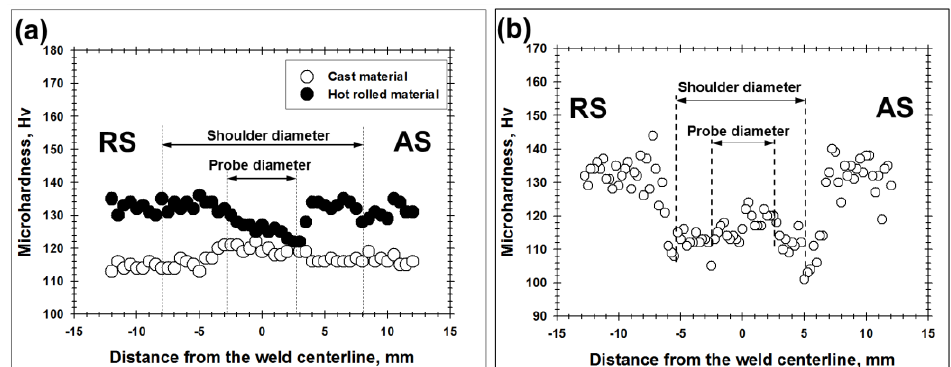
Figure 3. Microhardness profiles measured along the dotted lines shown in Figure 1 in ( a ) Al-Mg-Sc alloy and ( b ) 6061 alloy. For clarity, the probe- and shoulder diameters are indicated. AS and RS are advancing side and retreating side, respectively.